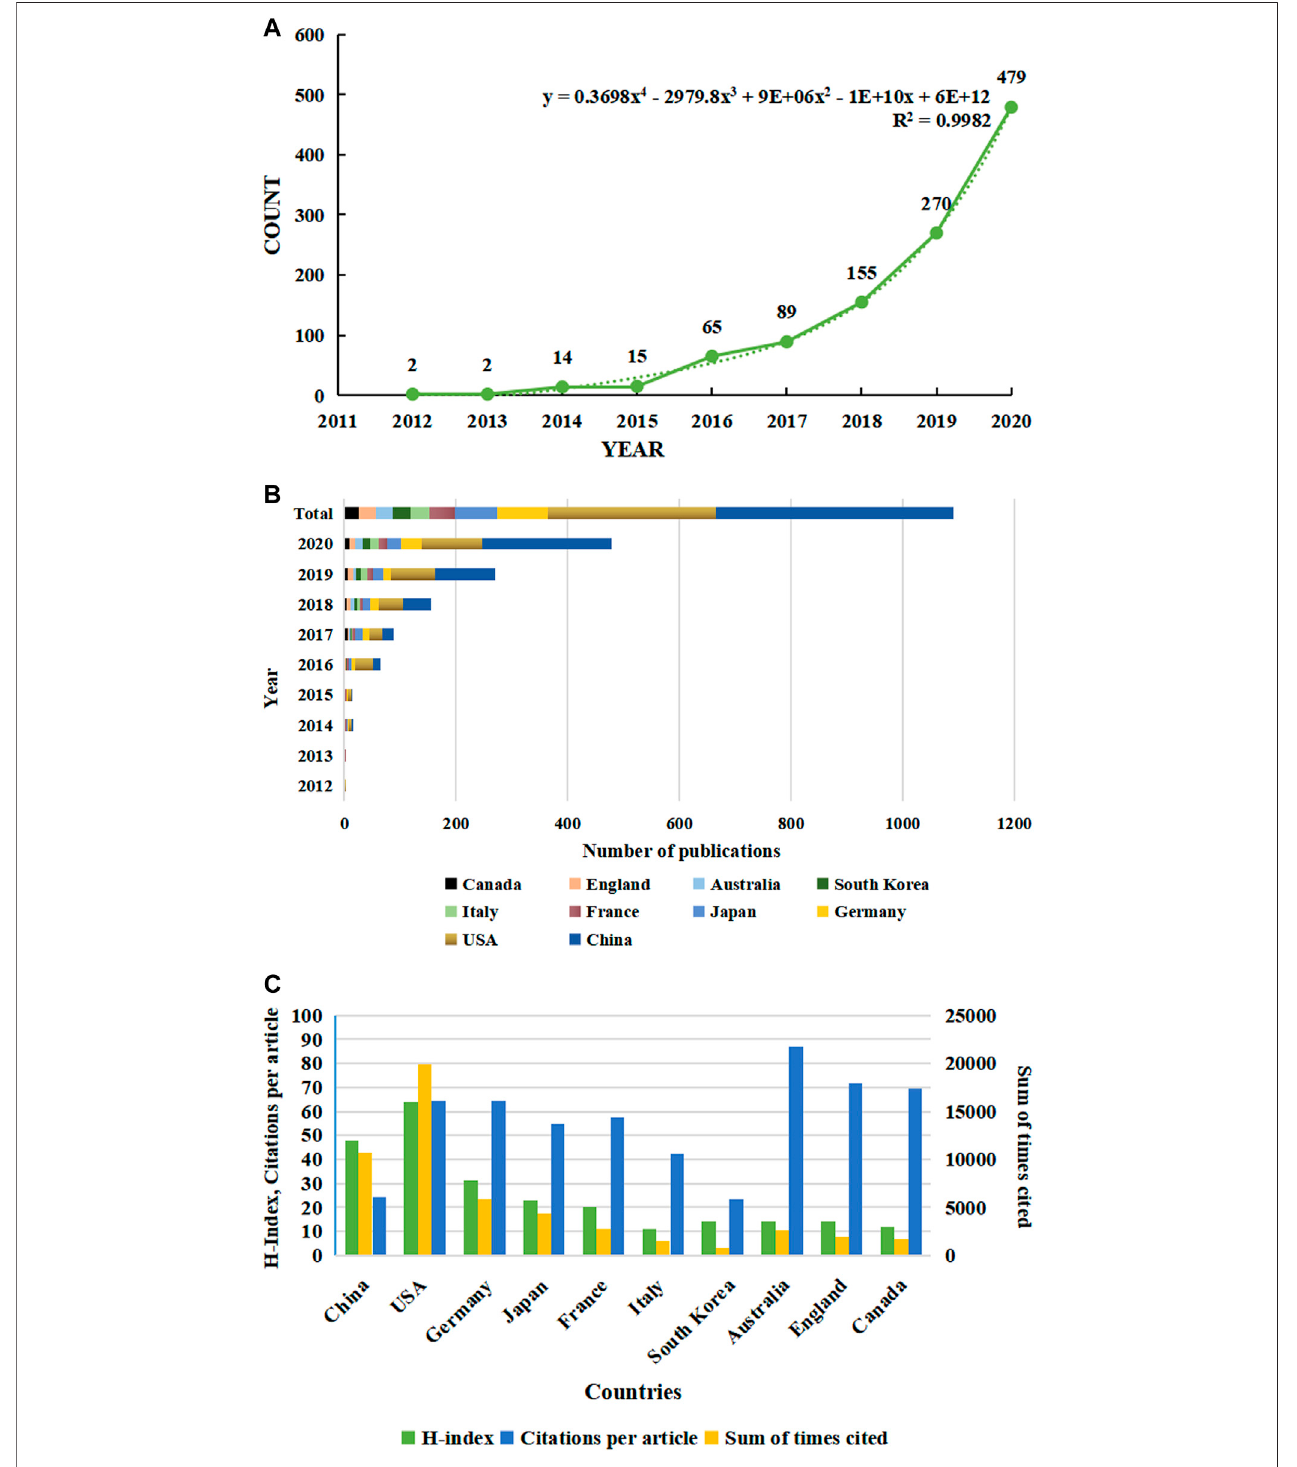
FIGURE1| Trendsinthenumberofpublicationsandanalysisofcountry/regionsinferroptosisincancerresearch. (A) Theannualworldwidepublicationoutput. (B) Growth trends in the publication output from the top 10 countries. (C) H-index, citations per article, and total number of citations for the top 10 country/regions.